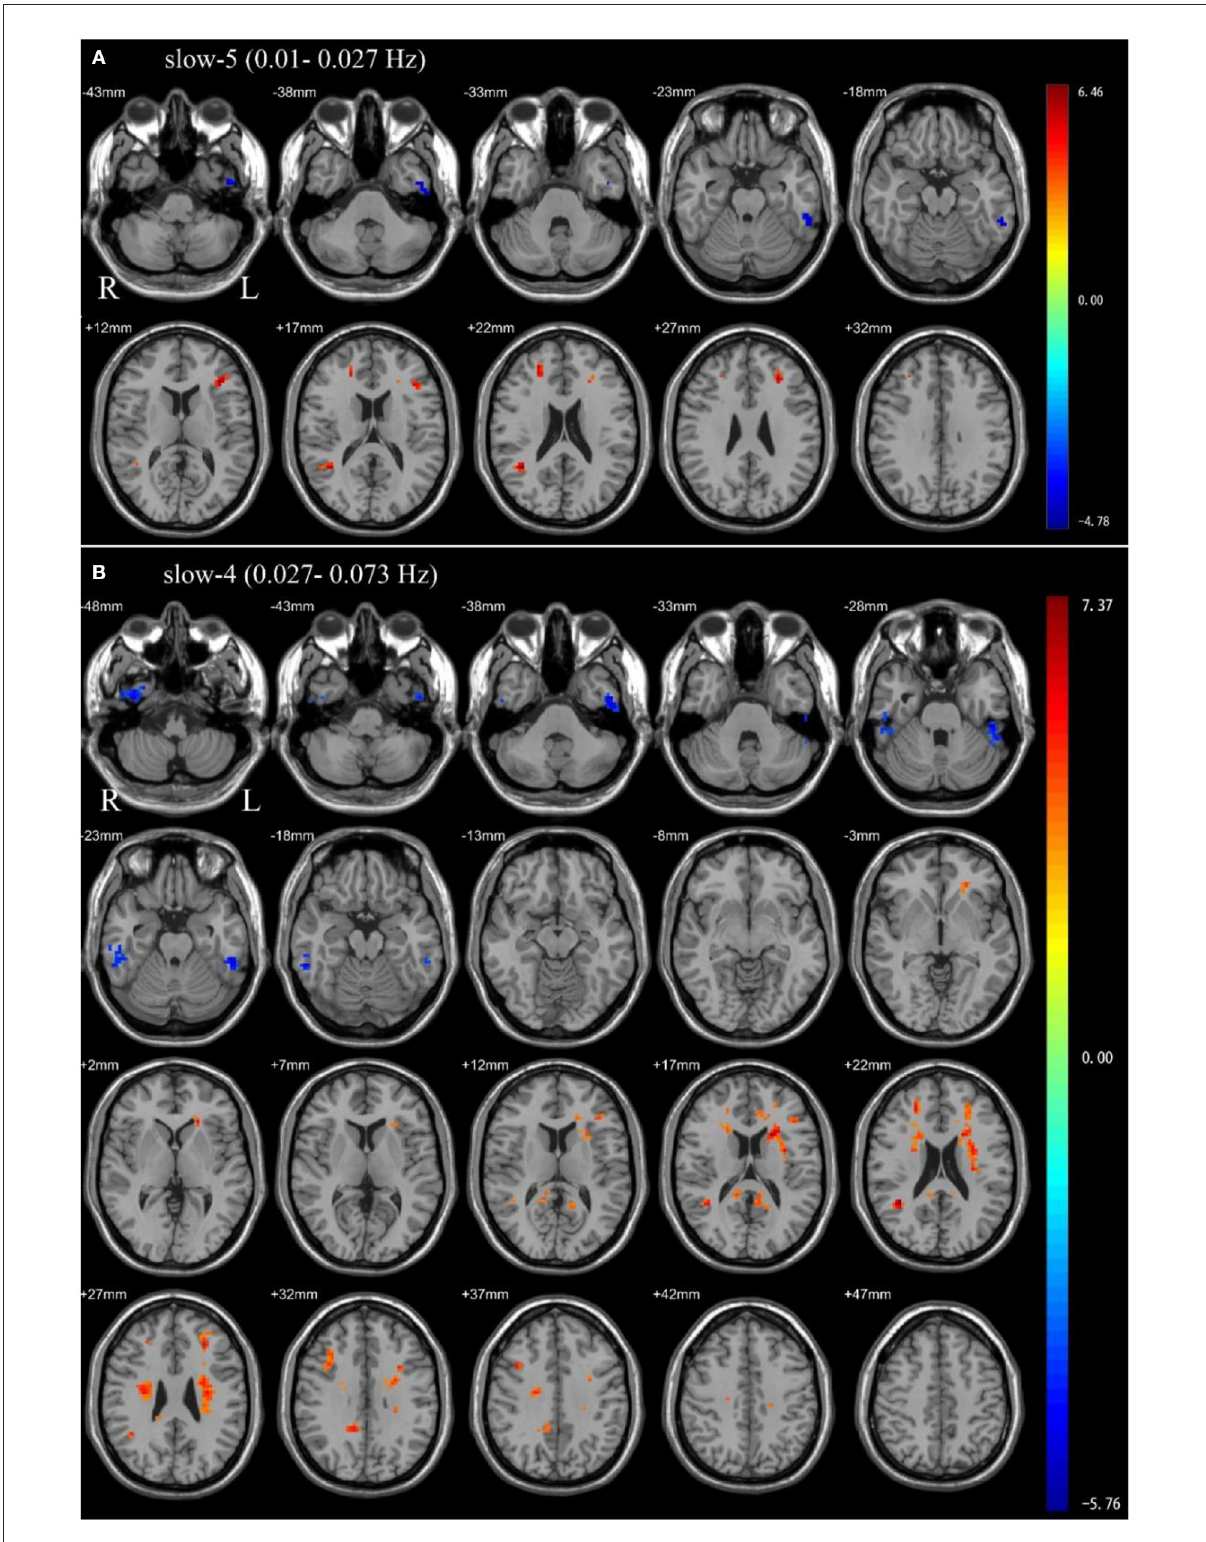
FIGURE1 Independent sample t -test between health control groups and pre-CPAP OSA patients: (A) slow-5 frequency band (0.01–0.027Hz). (B) slow-4 frequency band (0.027–0.073Hz). Results were reported at voxel-level p < 0.001 and cluster-level p < 0.05, GRF